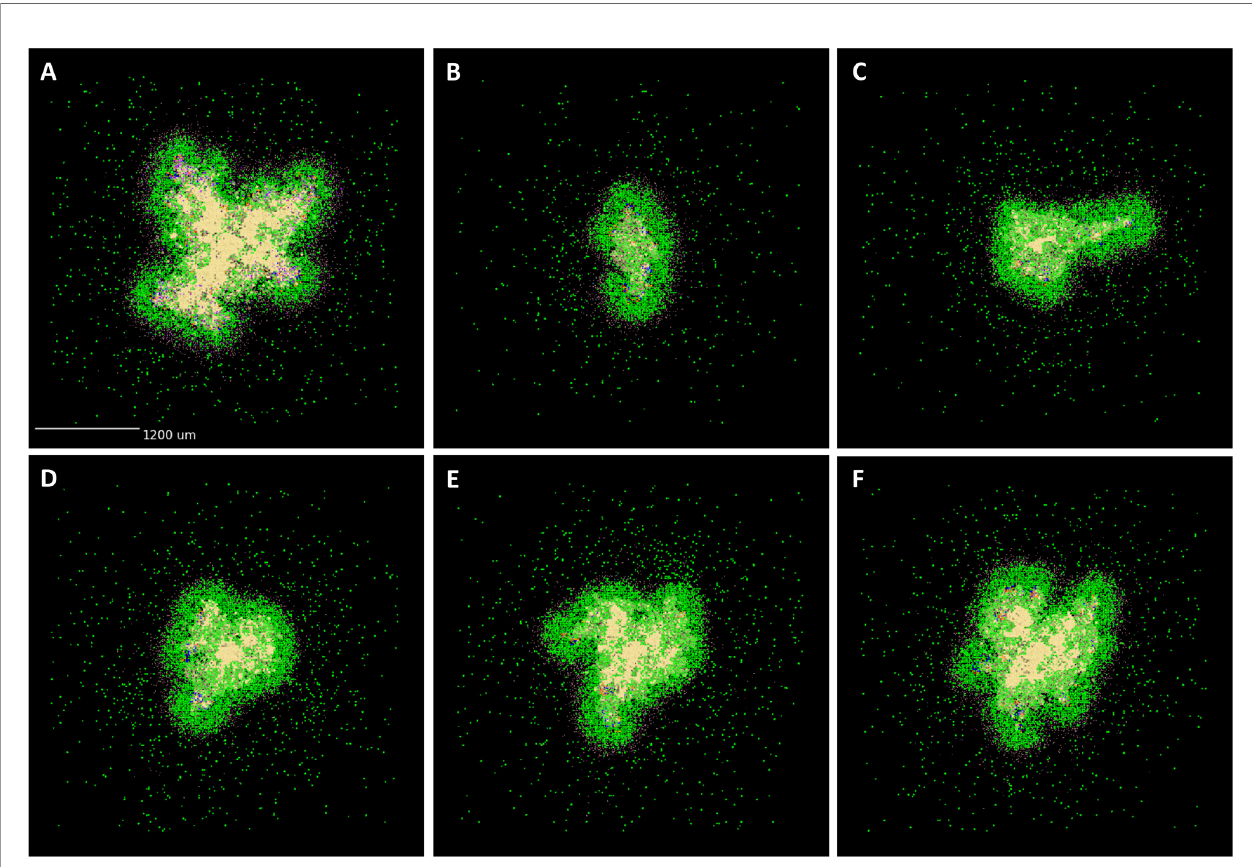
FIGURE 5 | Spatial outcomes for virtual neutrophil deletion and depletion studies. Simulated granulomas at day 200 PI. Macrophages (green – resting, orange – infected, red – chronically infected, blue – activated), Neutrophils (purple), T cells (Tgam – pink, Tcyt – maroon, Treg – cyan), extracellular Mtb (brown), and caseum (beige) are shown. (A) As a wild-type control, we use a simulated granuloma that has high levels of CFU and abundant levels of neutrophils at 200 days PI. (B – F) are the virtual deletion and depletions using this same granuloma set. (B) Neutrophil deletion. Neutrophils are not present on the grid at any point during the simulation. (C – F) Virtual neutrophil depletion at days 25, 50, 75, and 100 PI,